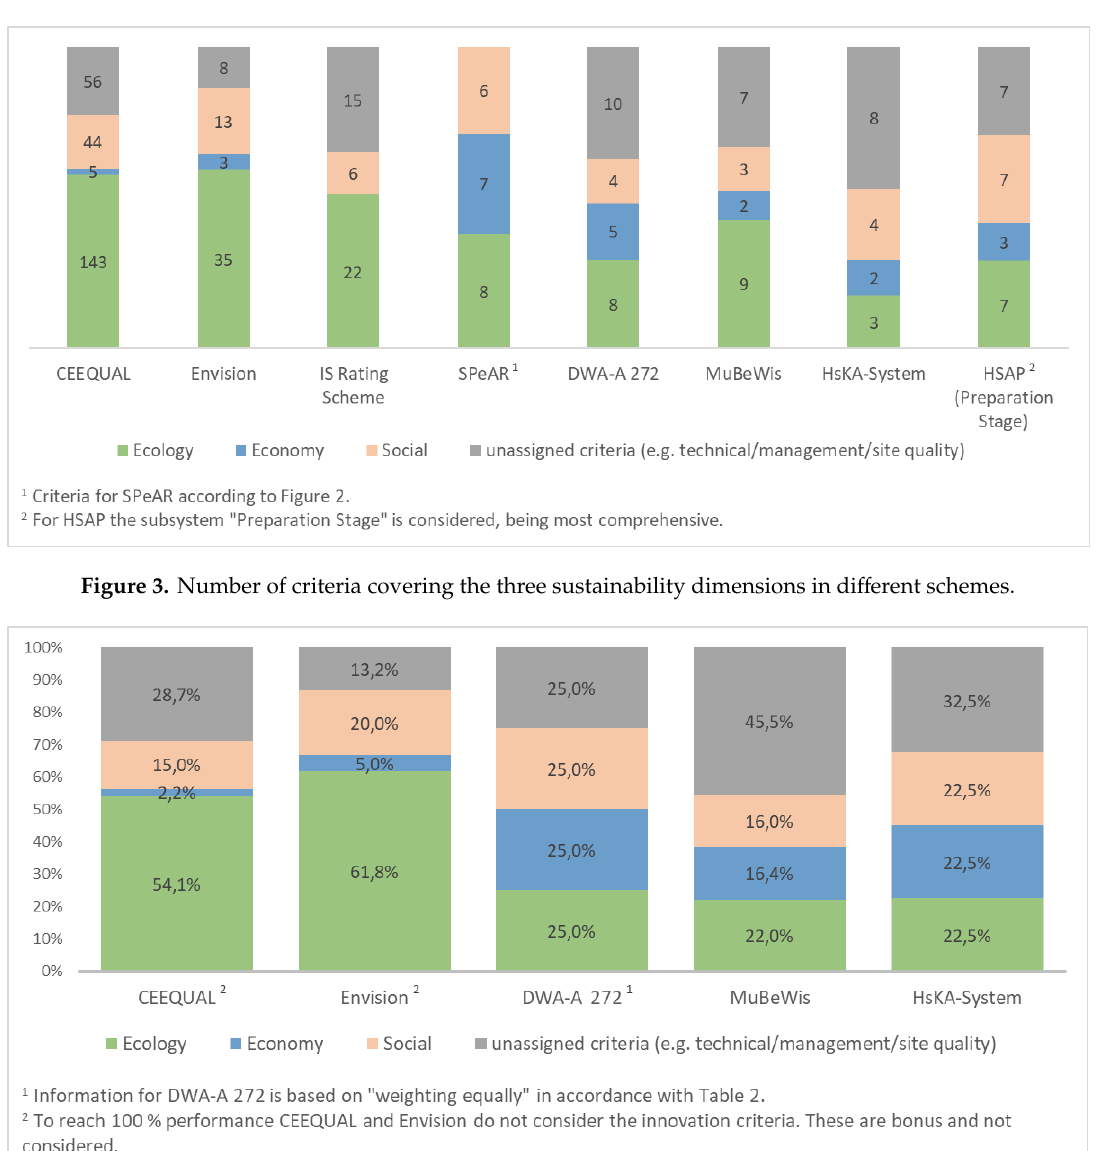
Figure 4. Weighting of the three sustainability dimensions in selected schemes.